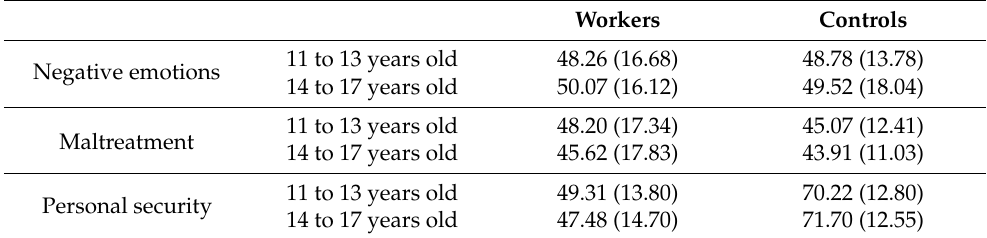
Table 2. Mean and standard deviation of each of the 3 factors of well-being, by age groups.